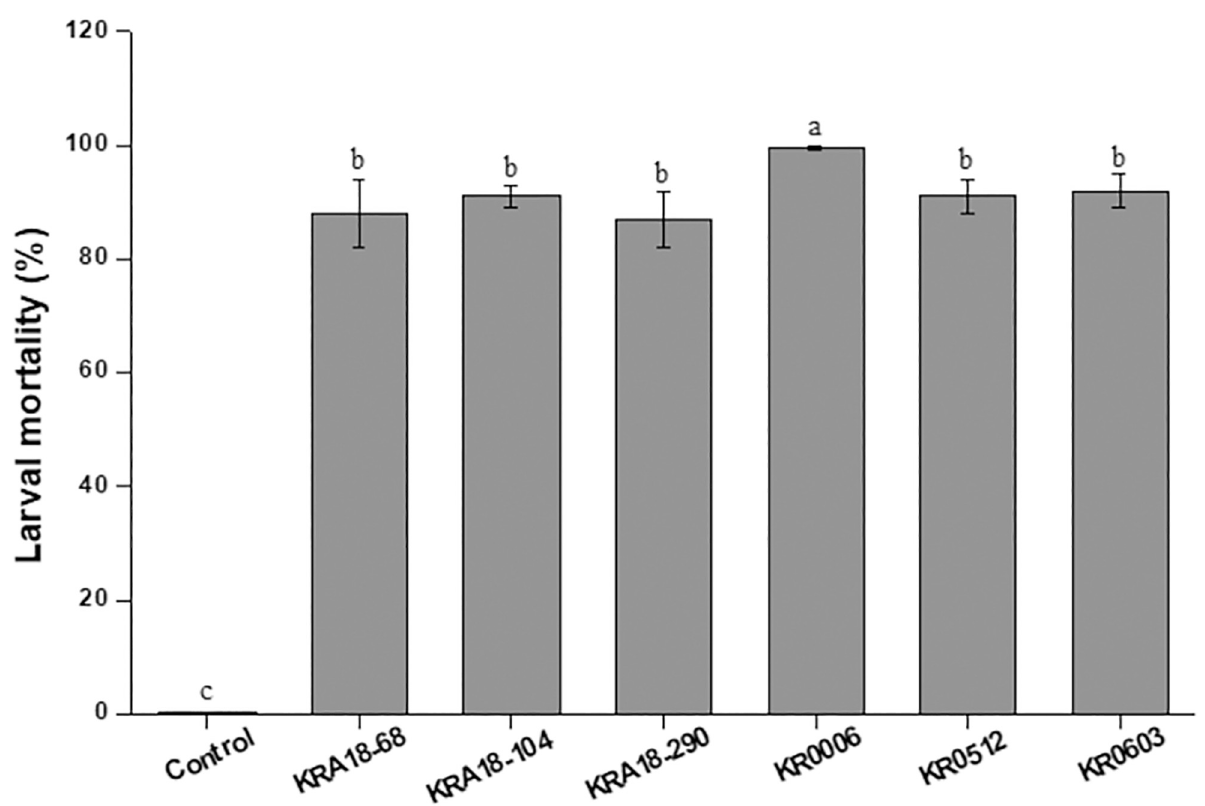
Fig 1. Insecticidal activity of the actinobacteria strains against Plutella xylostella . Second instar larvae of P . xylostella were treated with undiluted culture filtrate of each actinobacterium strain using the cabbage leaf dipping method. The mortality was evaluated three days after inoculation. The vertical bars indicate the standard errors of the means and different letters above the error bars indicate a significant difference in the Fisher’s LSD test (P < 0.05).